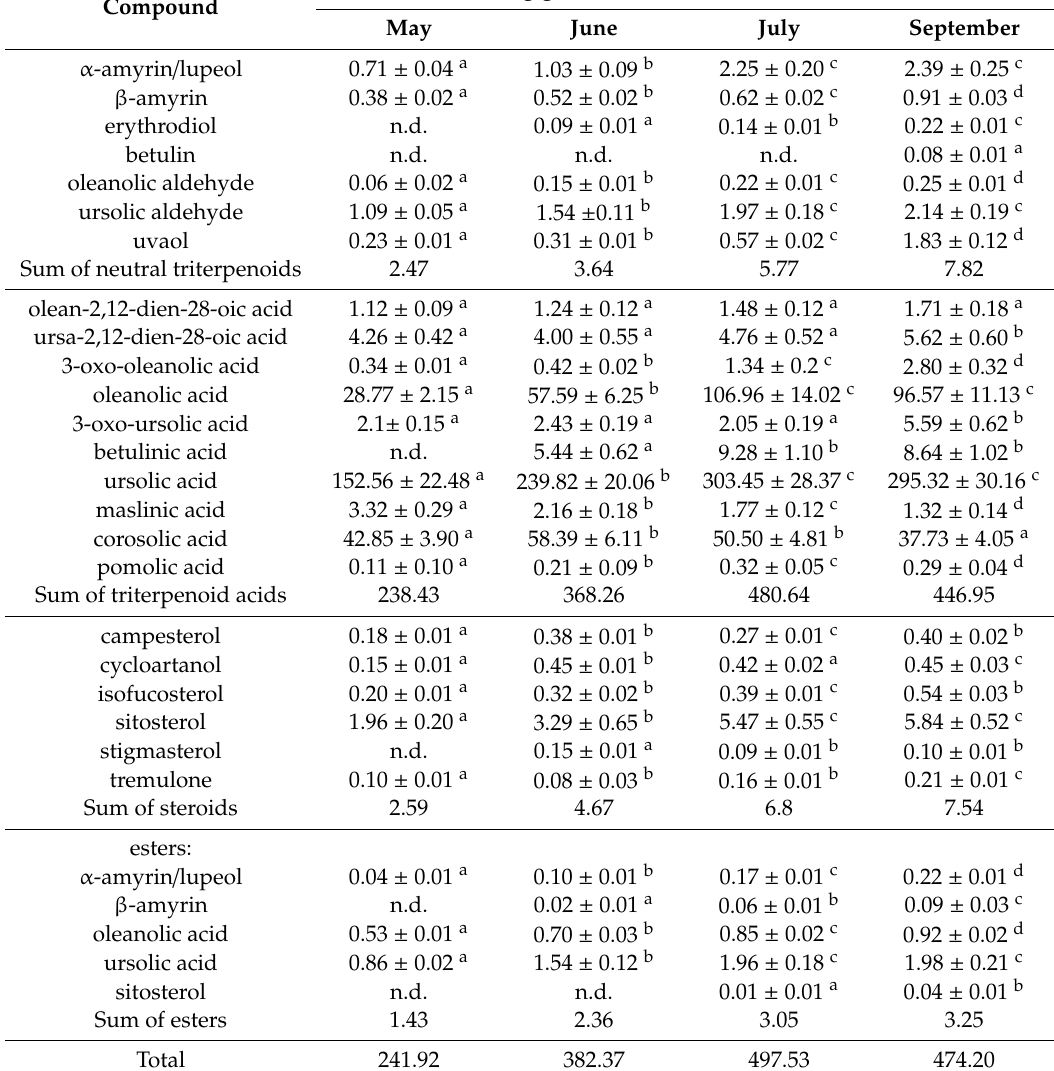
Table 3. Content of triterpenoids in cuticular waxes during apple ( Malus domestica ) var. Antonovka fruit development (very young fruit harvested in late May, young fruit in June, fully developed but not ripened fruit in July and ripened fruit in